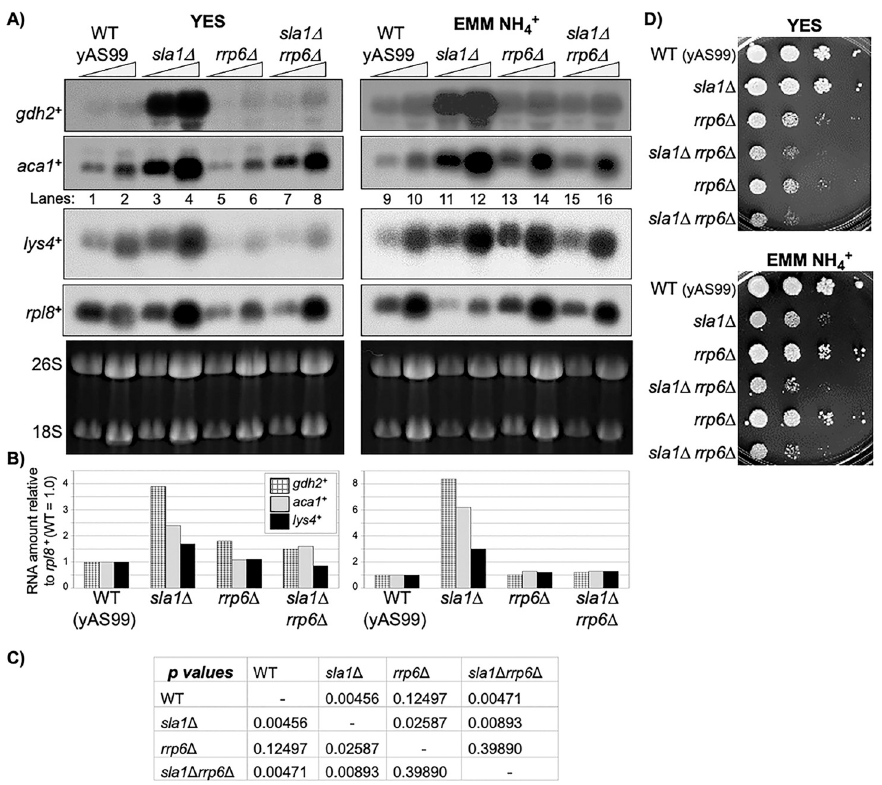
Fig 2. Evidence that the Rrp6 subunit of the nuclear exosome contributes to GAAC gene expression in sla1 Δ cells. A) Northern blot analysis of RNA from cells grown exponentially in rich medium (YES) (left) or Edinburgh minimal medium (EMM) containing NH4 + (right). Total RNA, 5 and 10 μ g of each sample were separated on a 1% denaturing agarose gel, transferred to a GeneScreen Plus nylon membrane, and subjected to sequential hybridization with 32 P- labelled probes for mRNAs ghd2 + , aca1 + , lys4 + and rpl8 + the latter of which serves as a quantitative normalization control, as indicated. A photo of the ethidium bromide stained agarose gel prior to transfer is shown as the bottom panel with the 18S and 26S rRNA bands indicated. B) Quantitation of the ghd2 + , aca1 + and lys4 + bands relative to the rpl8 + mRNA that encodes ribosomal protein L8. Values represented by each bar indicate two separate RNA sample loadings per experiment (technical duplicates), relative to WT which was set to 1. C) The quantitative data reported for ghd2 + and aca1 + mRNA levels in both panels of B were used to derive p -values using a basic T-test of statistical significance of the differences indicated. D) Cells were grown in liquid medium and serial dilutions were spotted to the indicated plates and incubated at 32˚C for 2 to 6 days. Strains: yAS99 (WT); yAS113 ( sla1 Δ ); yYH7a ( rrp6 Δ ); CY1670 ( sla1 Δ rrp6 Δ